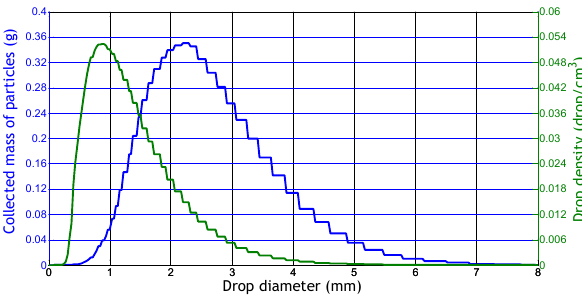
Figure 1: Collected mass of particles and drop density as a function of the drop diameter (using Figure 1. Collected mass of particles and drop density as a function DESCAM) of the drop diameter (using DESCAM).